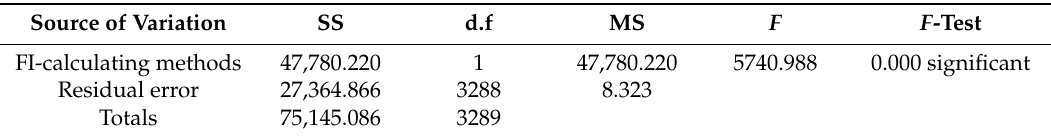
Table 3. Analysis of variance between the FI-calculating methods presented in Equation (1) and the proposed Equation